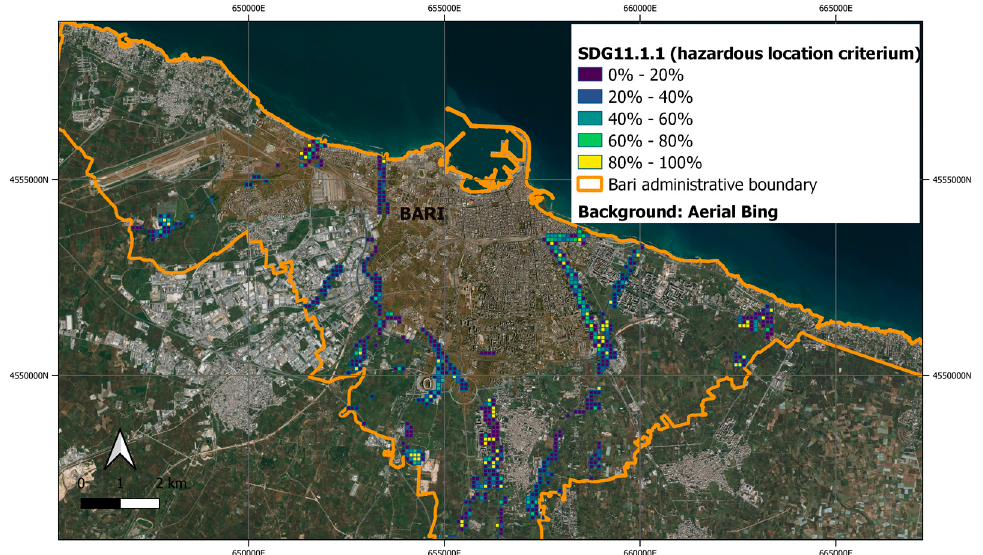
Figure 19. SDG 11.1.1 sub-indicator (2) Proportion of households living in housing residing on or near hazardous areas.